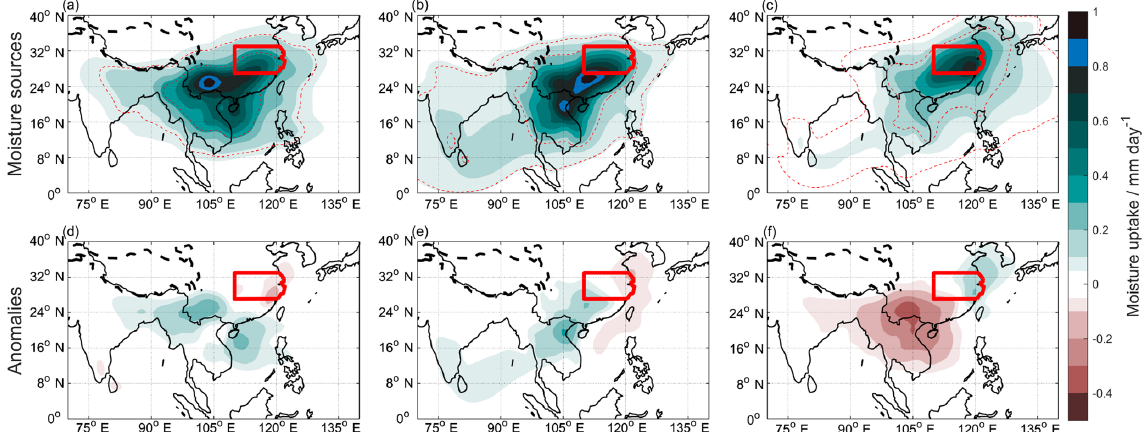
Figure 3. Two-month mean moisture sources for YRV for April–September. (a–c) show the mean moisture sources for (a) late spring (April–May), (b) midsummer (June–July), and (c) extended late summer (August–September). The lower panels show the (d) April–May, (e) June–July, and (f) August–September anomalies compared to the April–September mean. The target region (red) and 4000m elevation of the Tibetan Plateau (dotted contour) are shown. The 50th and 80th percentiles of the mass contributed from moisture sources are shown in red dotted contours (a–c) . The units are millimeters per day (mmd − 1